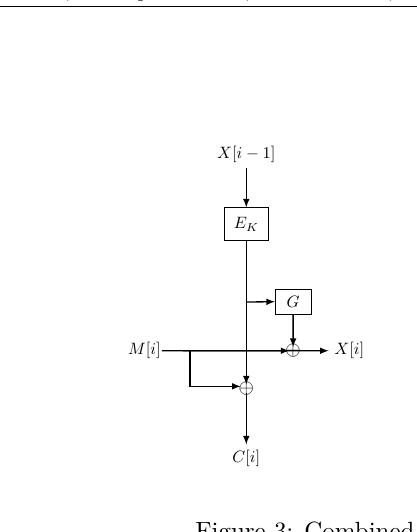
Figure 3: Combined